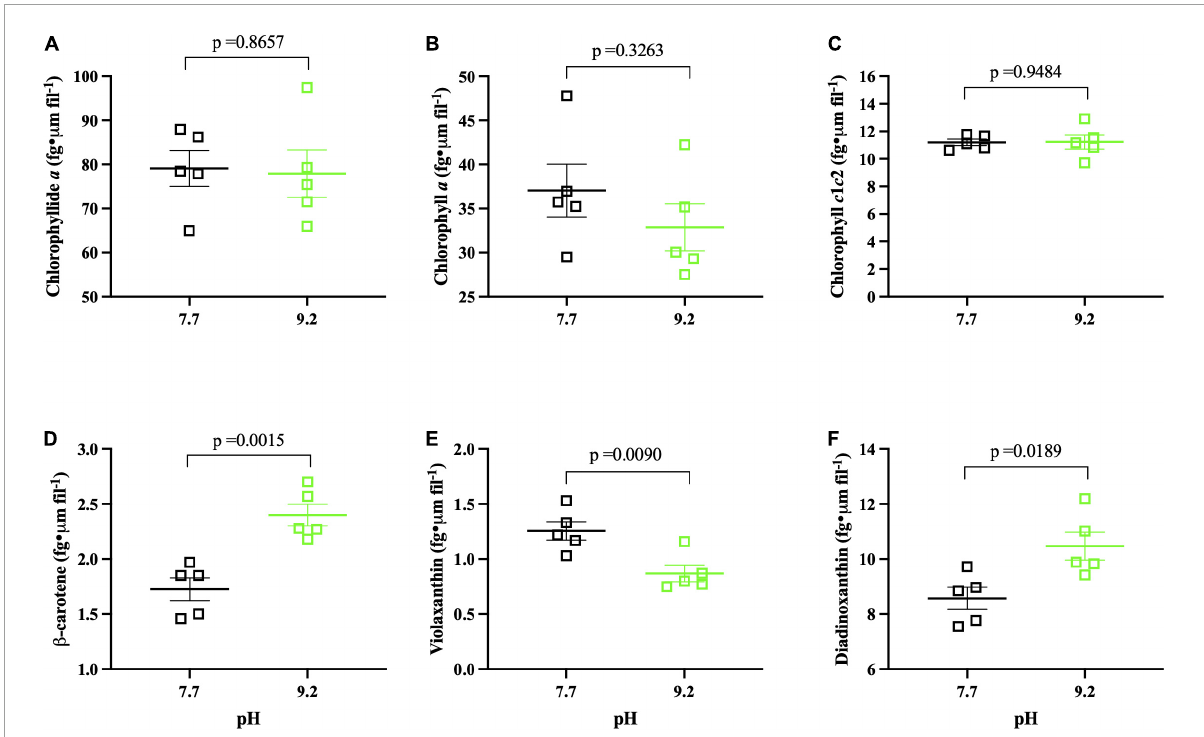
FIGURE4 Photopigment pH assay results ( n = 5) collected at (T f ). pH 7.7 replicates denoted by open, black squares. pH 9.2 replicates denoted by open, green squares. The group mean of treatment replicates indicated by the central bar and variability is indicated by error bars representing the standard error of the mean (SEM). (A) Chlorophyllide a (fg • µ m fil - 1 ) of F. crotonensi s filaments. (B) Chlorophyll a (fg • µ m fil - 1 ) of F. crotonensi s filaments. (C) Chlorophyll c 1 c 2 (fg • µ m fil - 1 ) of F. crotonensi s filaments. (D) β -Carotene (fg • µ m fil - 1 ) of F. crotonensi s filaments.